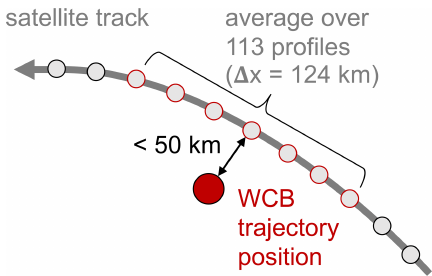
Figure 1. Schematic illustration of the method to attribute several satellite profiles to a matching ERA5-based WCB trajectory in the climatological